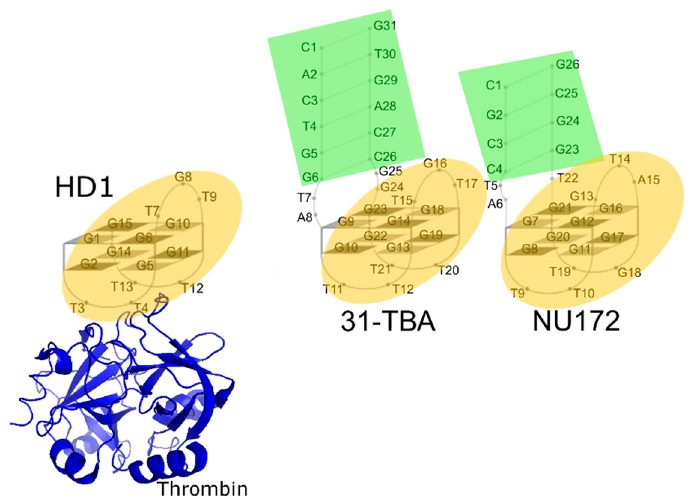
Figure 1. Schematic drawing of complexes of aptamer HD1 with thrombin and HD1-like aptamers 31-TBA and NU172. Modules are indicated by color: duplexes in green and G-quadruplexes in orange. Aptamer HD1 recognizes and binds thrombin exosite I with TT-loops (T 3 T 4 and T 12 T 13 ).